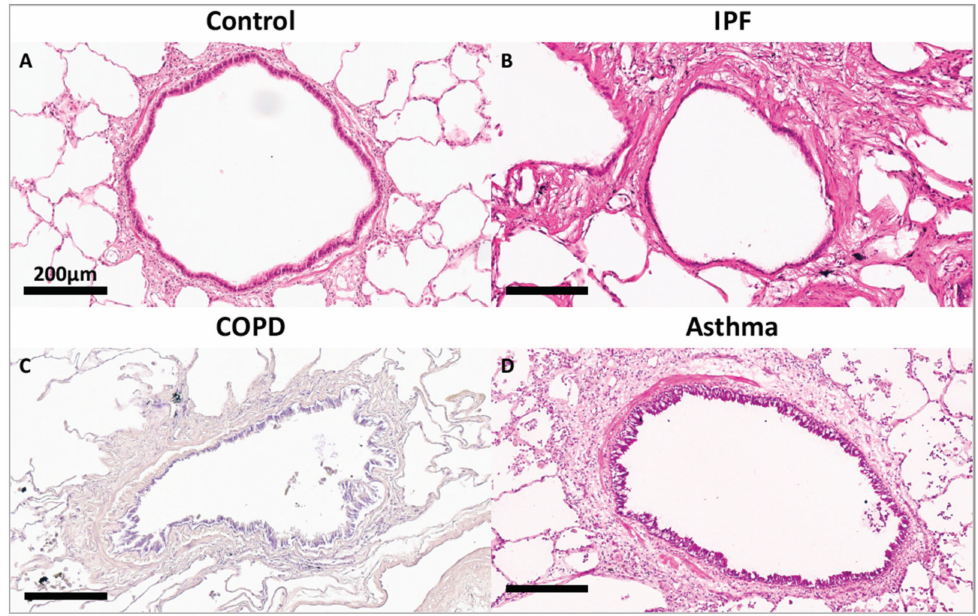
Figure 3. Representative image of a terminal bronchiole stained with hematoxylin and eosin from from a patient with mild chronic obstructive pulmonary disease. ( D ) Terminal bronchiole stained with Masson’s trichome from a lung from a patient with